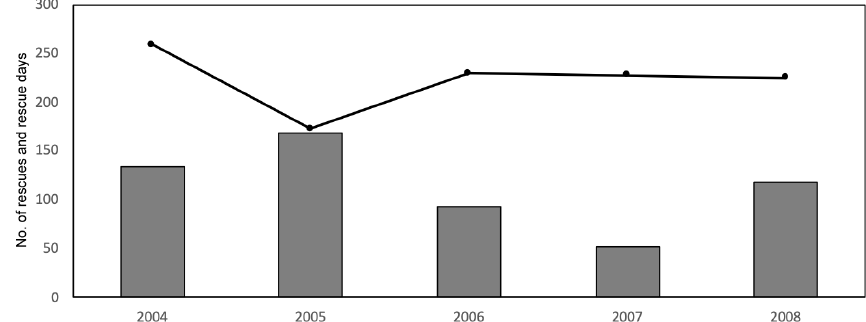
Figure 3. Interannual variation in number of rescues and rescue days at Pensacola Beach between 2004 and 2008.